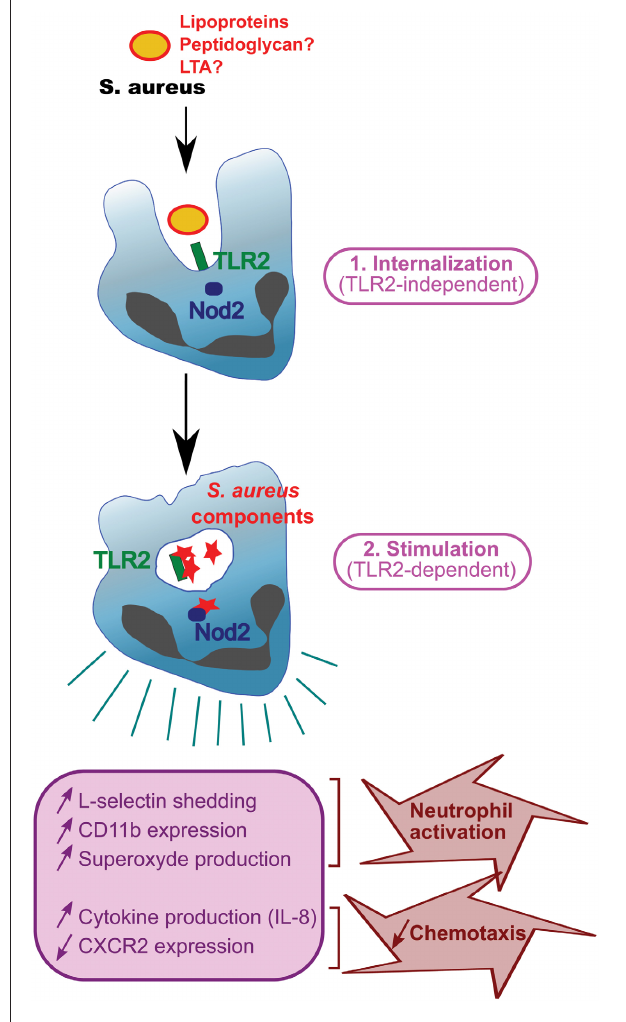
FIGURE 2 | Function of TLR2 during phagocytosis. S. aureus with surface TLR2 ligands (lipoproteins, peptidoglycan, and LTA) is internalized in a TLR2-independentmanner and digested in phagosomes. Staphylococcal components are released and stimulate PRRs e.g., TLR2 or Nod2, resulting in phagocyte activation and production of